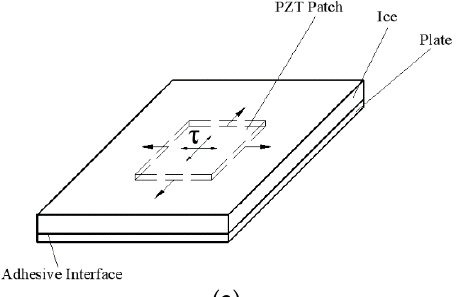
Table 1. Properties of